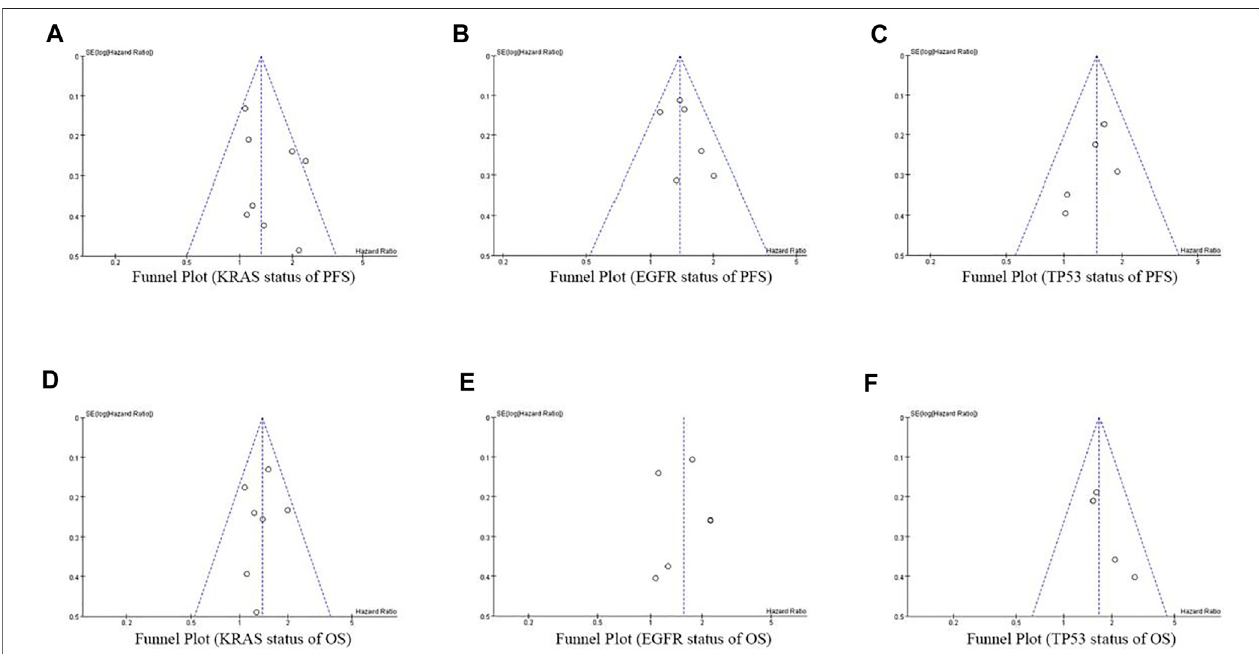
FIGURE 8 | Funnel Plot of objective responses according to KRAS/EGFR/TP53 status of PFS and OS in cancer patients treated with ICIs.